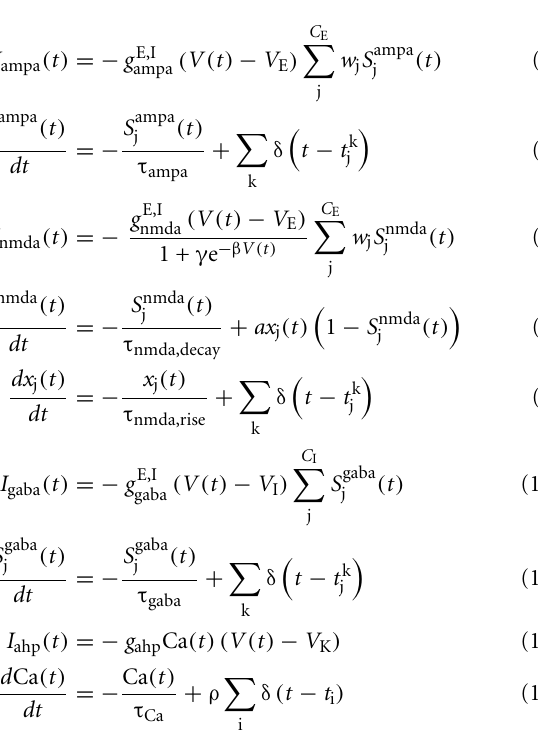
FIGURE 1 | (A) Biophysically plausible spiking network of integrate-and-fire neurons with spike-frequency adapting mechanism based on Ca 2 + -activated K + hyperpolarizing currents.There are four neuronal populations: one inhibitory (orange, I), one excitatory comprised of non-selective neurons (gray, ns), and two excitatory populations (red, 1 and blue, 2) within which neurons have similar stimulus selectivity. Arrows denote excitatory connections; lines ending to circles, inhibitory connections whereas lines ending to squares,